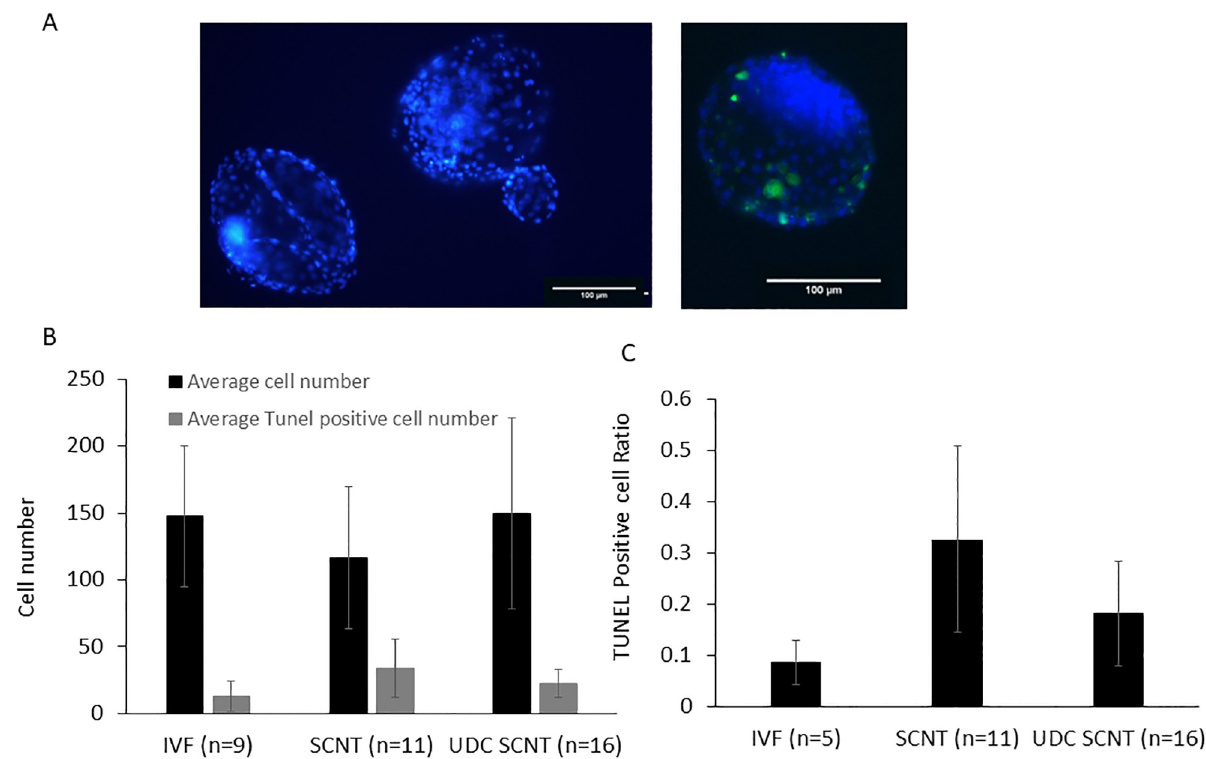
Fig 4. Embryo quality analysis A) Representative images of blastocyst with total cells (Blue) and TUNEL positive cells (Green), indicating DNA breaks B) Total cell number and TUNEL staining in 8 day embryos derived from IVF, SCNT with standard grown cells, and UDC SCNT. C) average ratio of tunnel positive cells to total cell counts. Error bars are